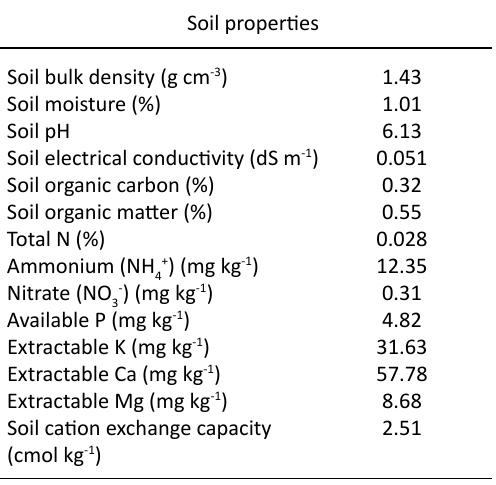
table 2. Chemical compositions of organic residues used in the experiment Chemical composition Organic